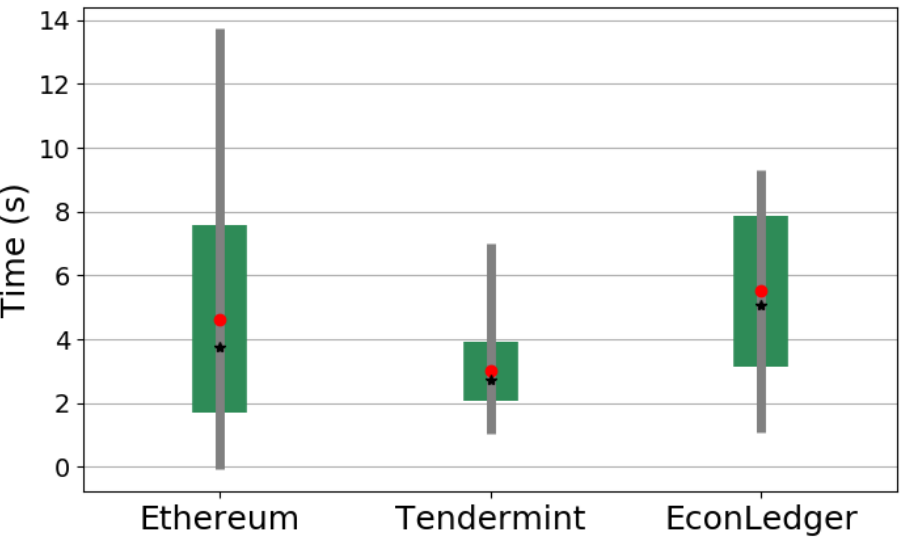
Figure 7. Time latency for committing transactions. Comparative evaluations on different blockchain